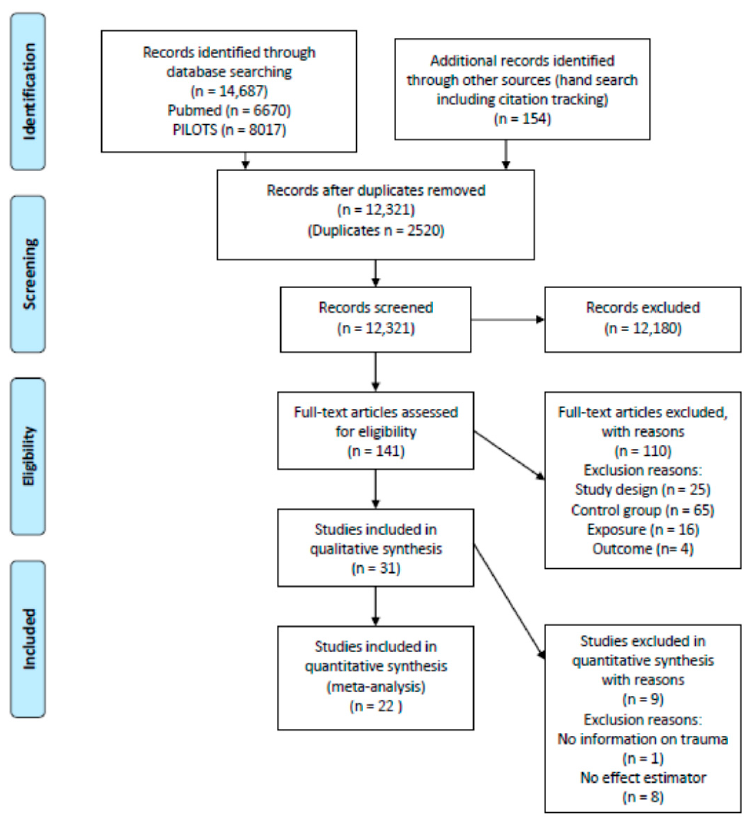
Figure 1. Flow diagram of inclusions and exclusions.